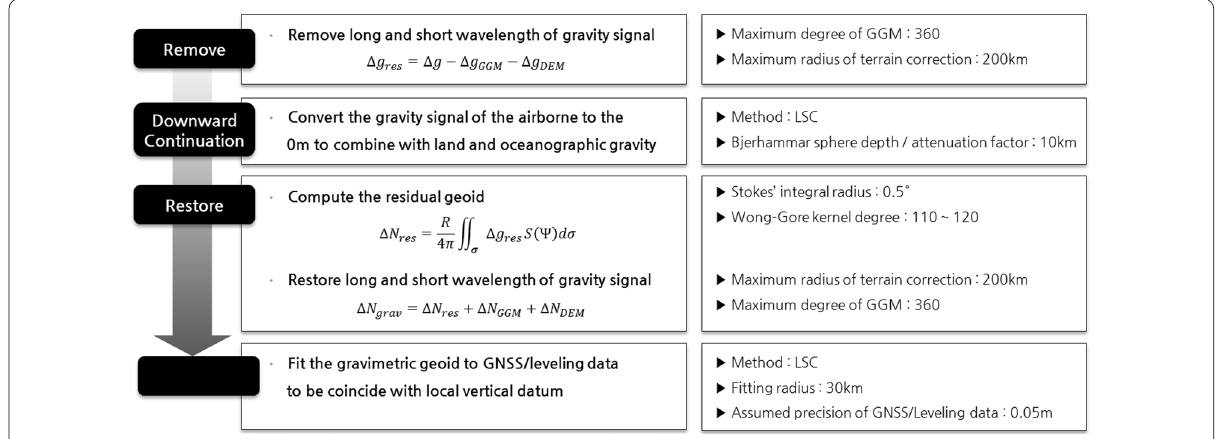
Fig. 6 Procedures for KNGeoid18 modeling and determined